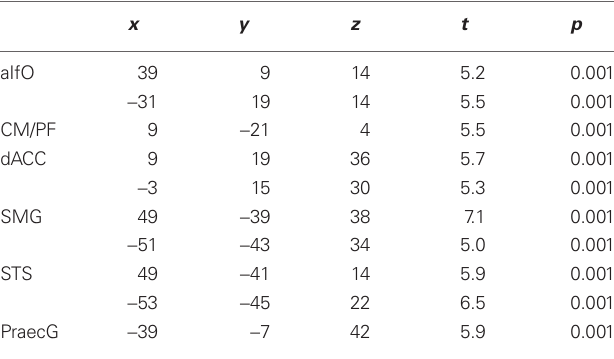
Table 5 | Comparison of effects of sexual arousal during anticipation and picture